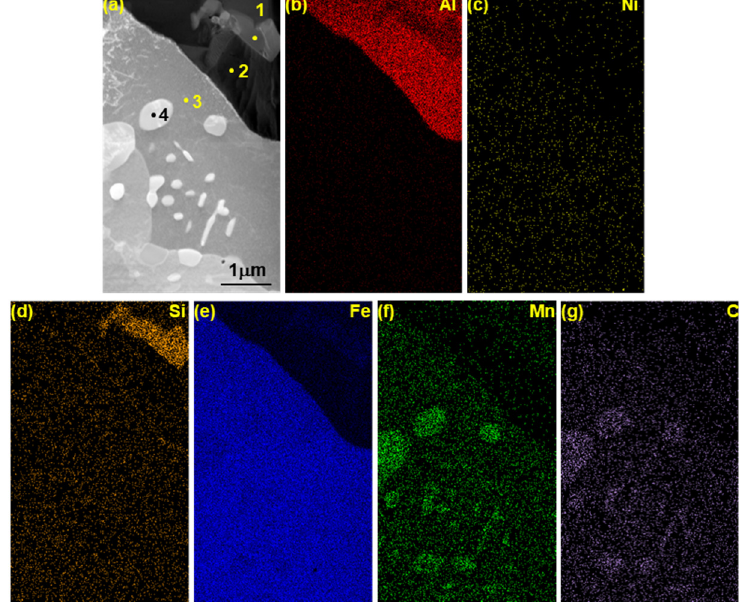
Figure 10. STEM results showing the of FIB specimen extracted from the area denoted by Y 1 in Figure 5. ( a ) HAADF Image, ( b – g ) results of EDS: ( b ) Al, ( c ) Ni, ( d ) Si ( e ) Fe, ( f ) Mn, and ( g ) C.